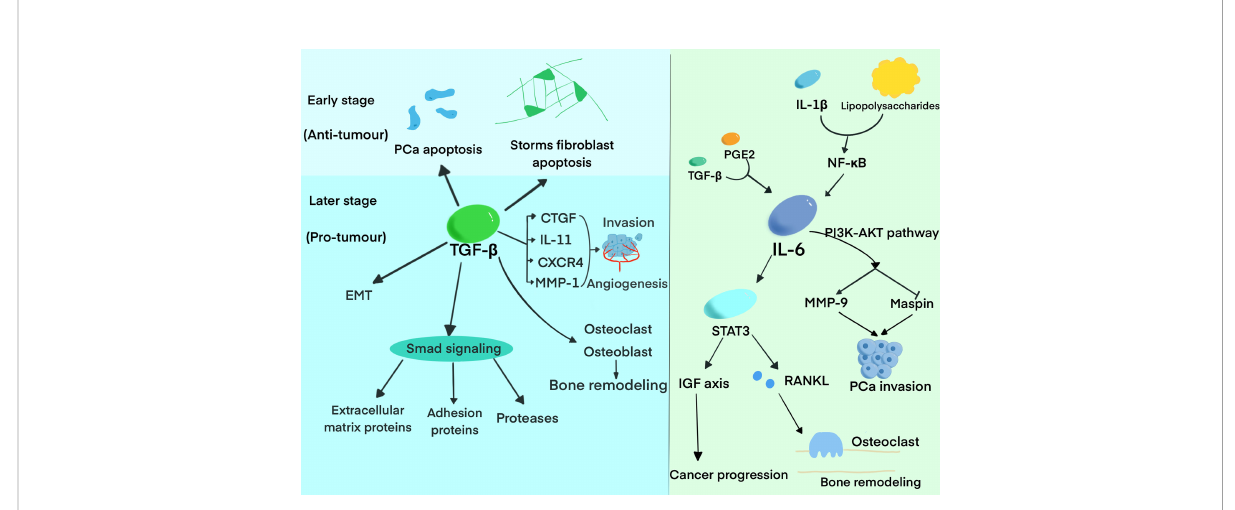
FIGURE 1 The roles of TGF- b and IL-6 in the progression and bone metastasis of PCa. The diagram summarized the pivotal functions of TGF- b and IL-6 has in the progression of bone